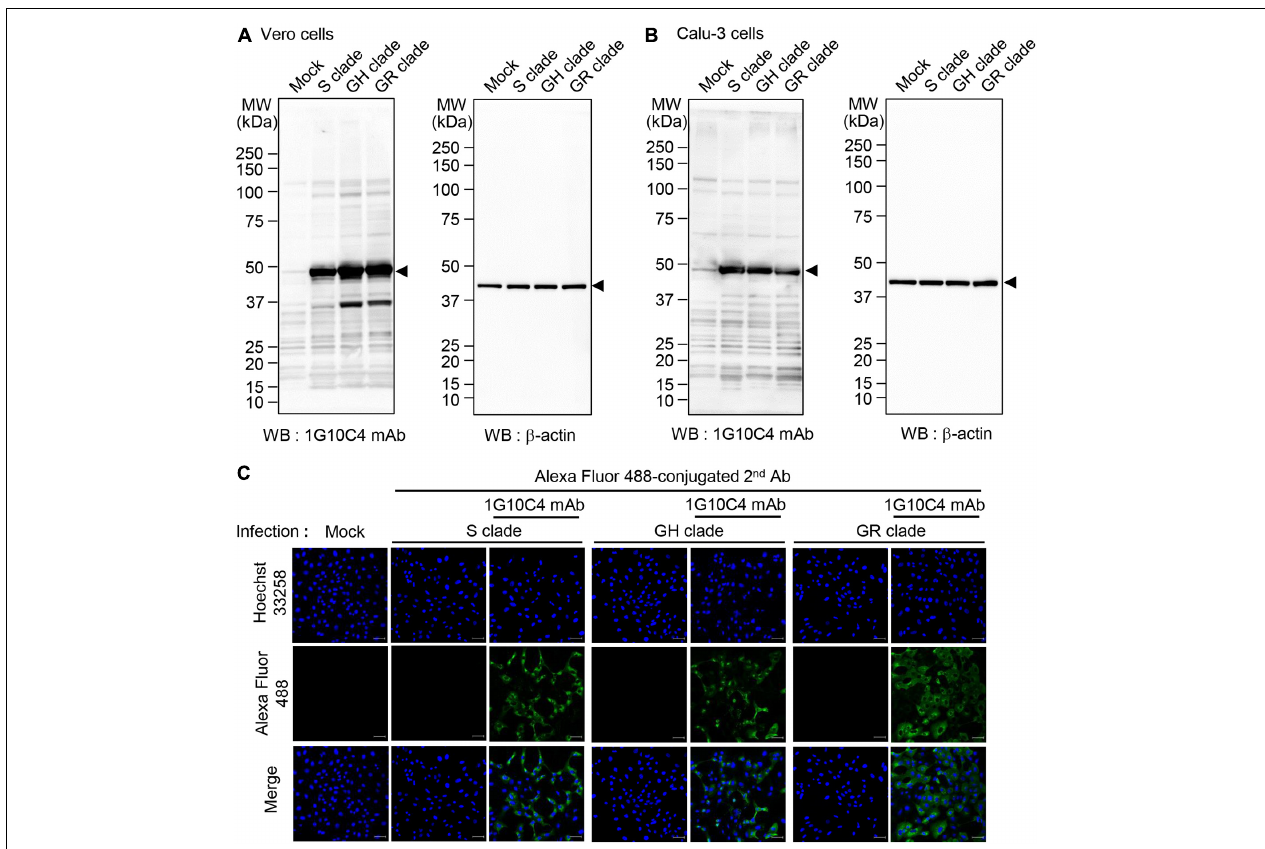
FIGURE 3 | Detection of N protein in cells infected with SARS-CoV-2 S, GH, or GR clade with anti-SARS-CoV-2 N protein-specific monoclonal antibody. (A,B) Western blot analyses for the detection of N protein in cells infected with SARS-CoV-2 S, GH, or GR clade. Vero cells (A) and Calu-3 cells (B) were infected with SARS-CoV-2 S, GH, or GR clade at a MOI of 0.1 for 72 h. Cell lysates were analyzed by western blotting with the anti-SARS-CoV-2 N protein-specific monoclonal antibody (clone 1G10C4 mAb). β -Actin was used as the loading control. (C) Confocal microscopy was used to detect N protein in cells infected with SARS-CoV-2 S, GH, or GR clade. Vero cells were cultured on cover glass in 12-well plates and infected with SARS-CoV-2 S, GH, or GR clade at a MOI of 0.1 for 48 h. The infected Vero cells were fixed with 4% paraformaldehyde and permeabilized with 0.1% Triton X-100. The cells were incubated with anti-SARS-CoV-2 N protein-specific monoclonal antibody or normal IgG and then with Alexa Fluor 488–conjugated goat anti-mouse IgG. Nuclei were stained with Hoechst 33258. Images were obtained by confocal microscope. Scale bar, 10 µ m.